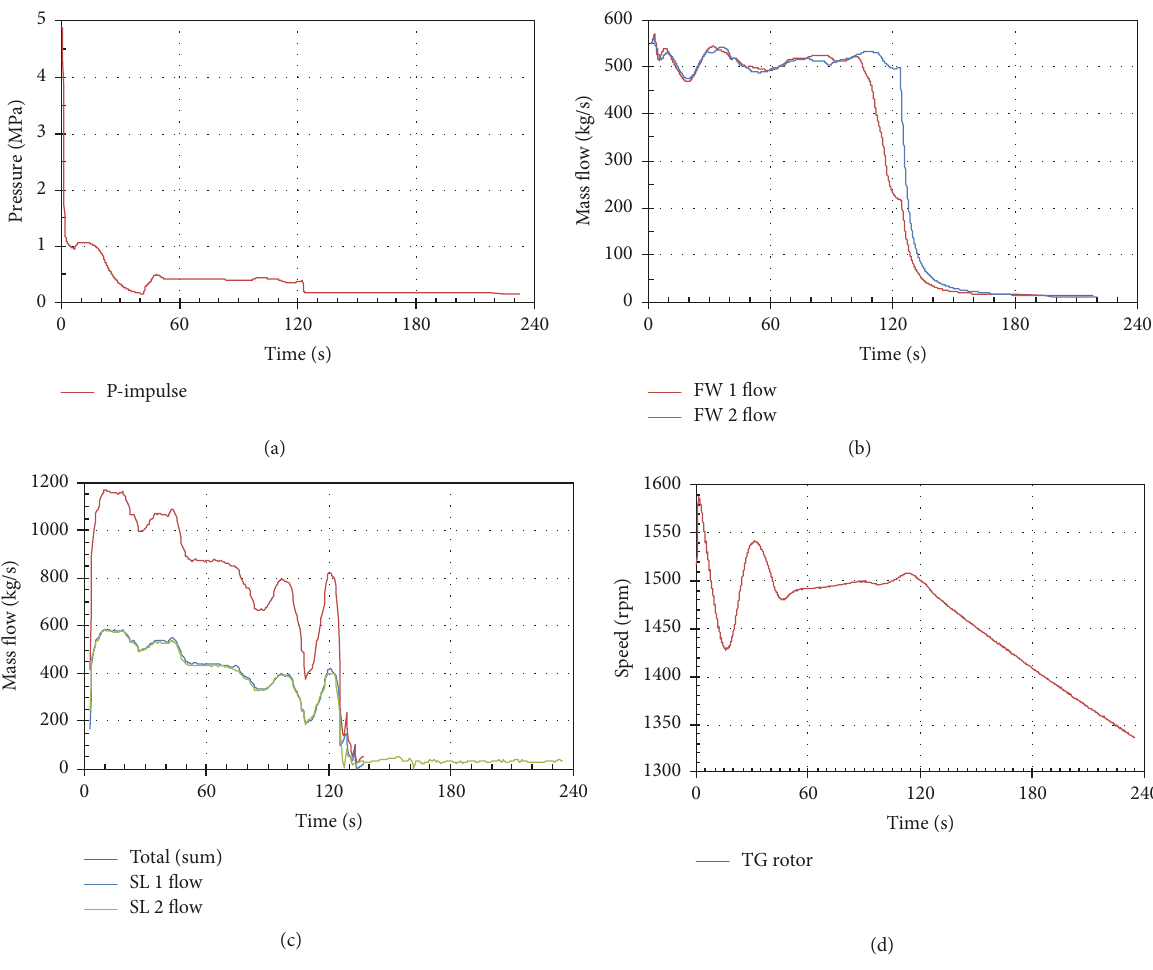
Figure 3: Measured plant parameters: (a) turbine first-stage (impulse) pressure; (b) feedwater flow to steam generator numbers 1 and 2; (c) steam line number 1 and number 2 steam flow and total flow (summed steam line flows); (d) turbine-generator rotor